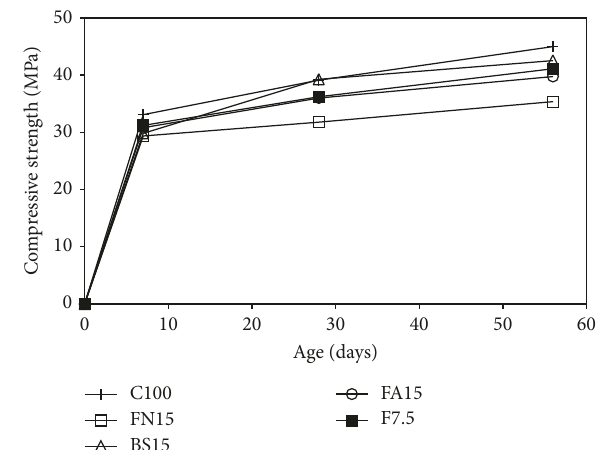
Figure 8: Compressive strength of the mortar (Series